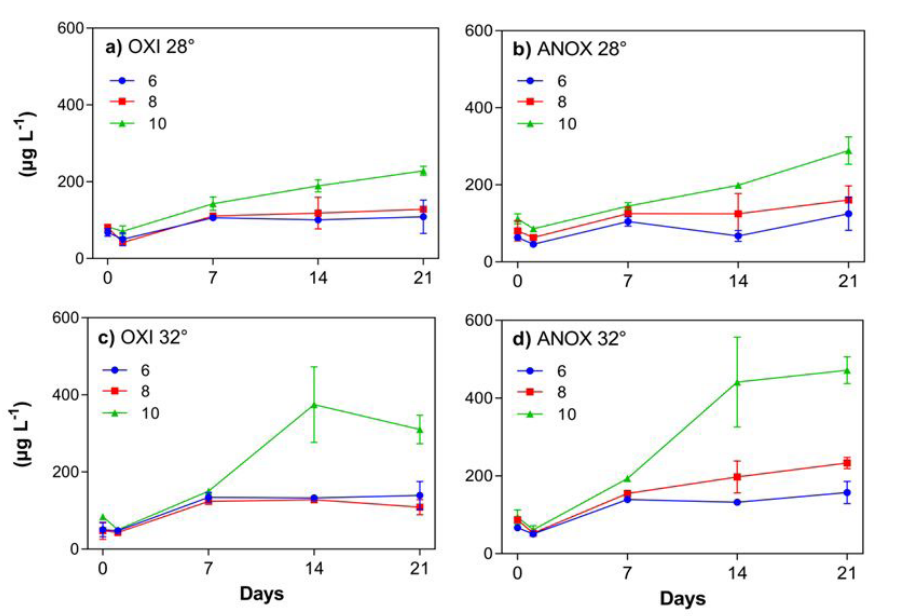
Figure 2. Variation in the soluble reactive phosphorus (SRP) in the overlying water of the Boqueirão reservoir during the 21 days of the experiment. a) At 28° C, under oxic conditions and pH values 6, 8 and 10; b) At 28° C, under anoxic conditions and pH values 6, 8 and 10; c) At 32° C, under oxic conditions and pH values 6, 8 and 10; d) At 32° C, under anoxic conditions and pH values 6, 8 and 10. OXI = oxic treatment (dissolved oxygen > 5 mg L -1 ) and ANOX = anoxic treatment (dissolved oxygen < 1 mg L -1 ).